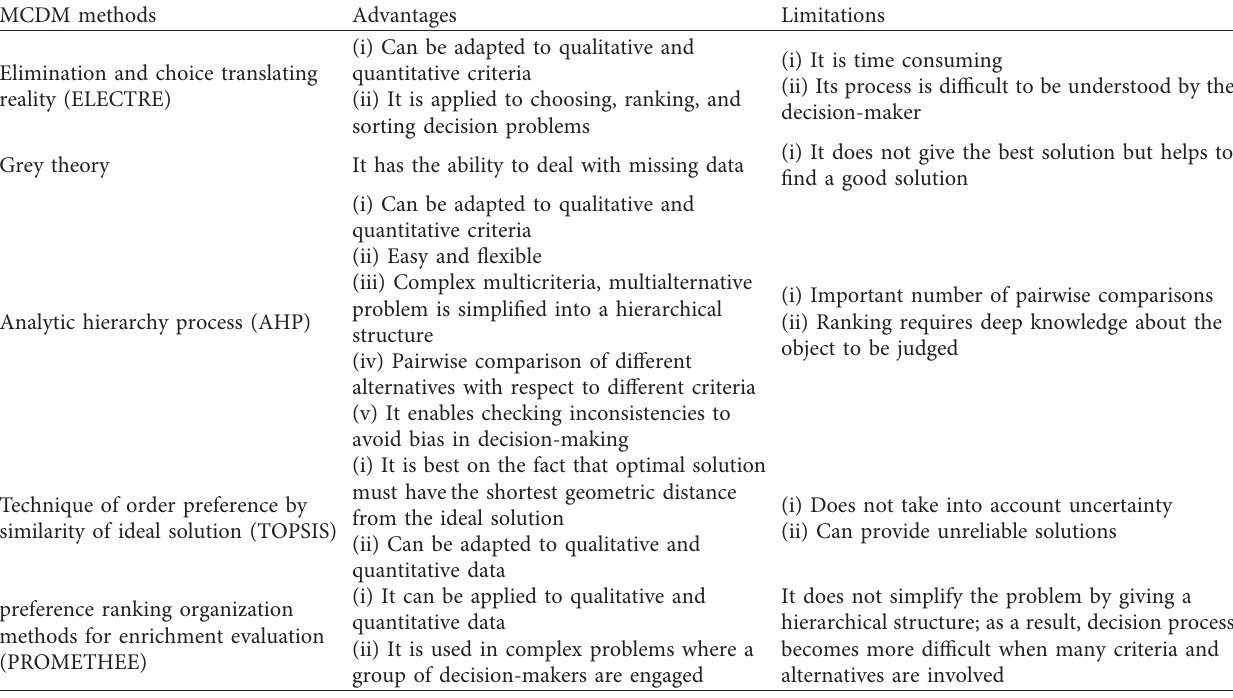
Table 4: Advantages and limitations of MCDM methods.